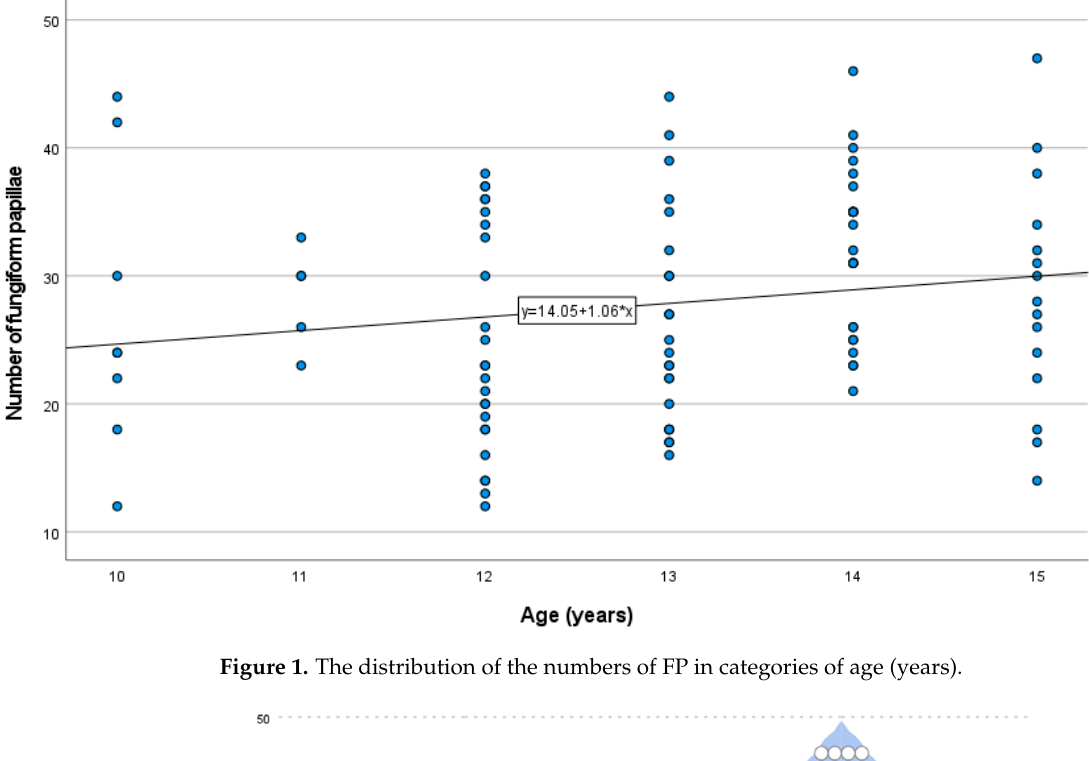
Figure 1. The distribution of the numbers of FP in categories of age (years). We also noticed differences in FP scores between tasters and nontasters ( p = 0.0211). The scores were higher in the group of tasters, for which the median score was 31 (23.0– 37.0), than in the group of nontasters, for which the median score was 25 (22.0–31.0) (Fig- ure 2).